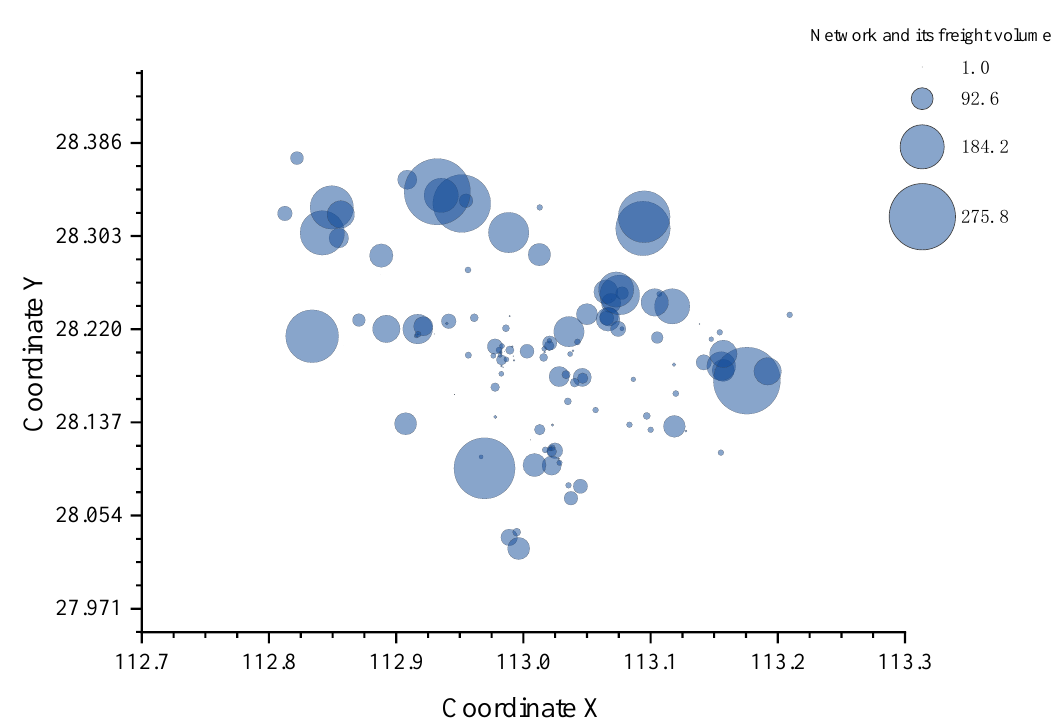
Figure 4. LTL-express demand heat map in Changsha City.